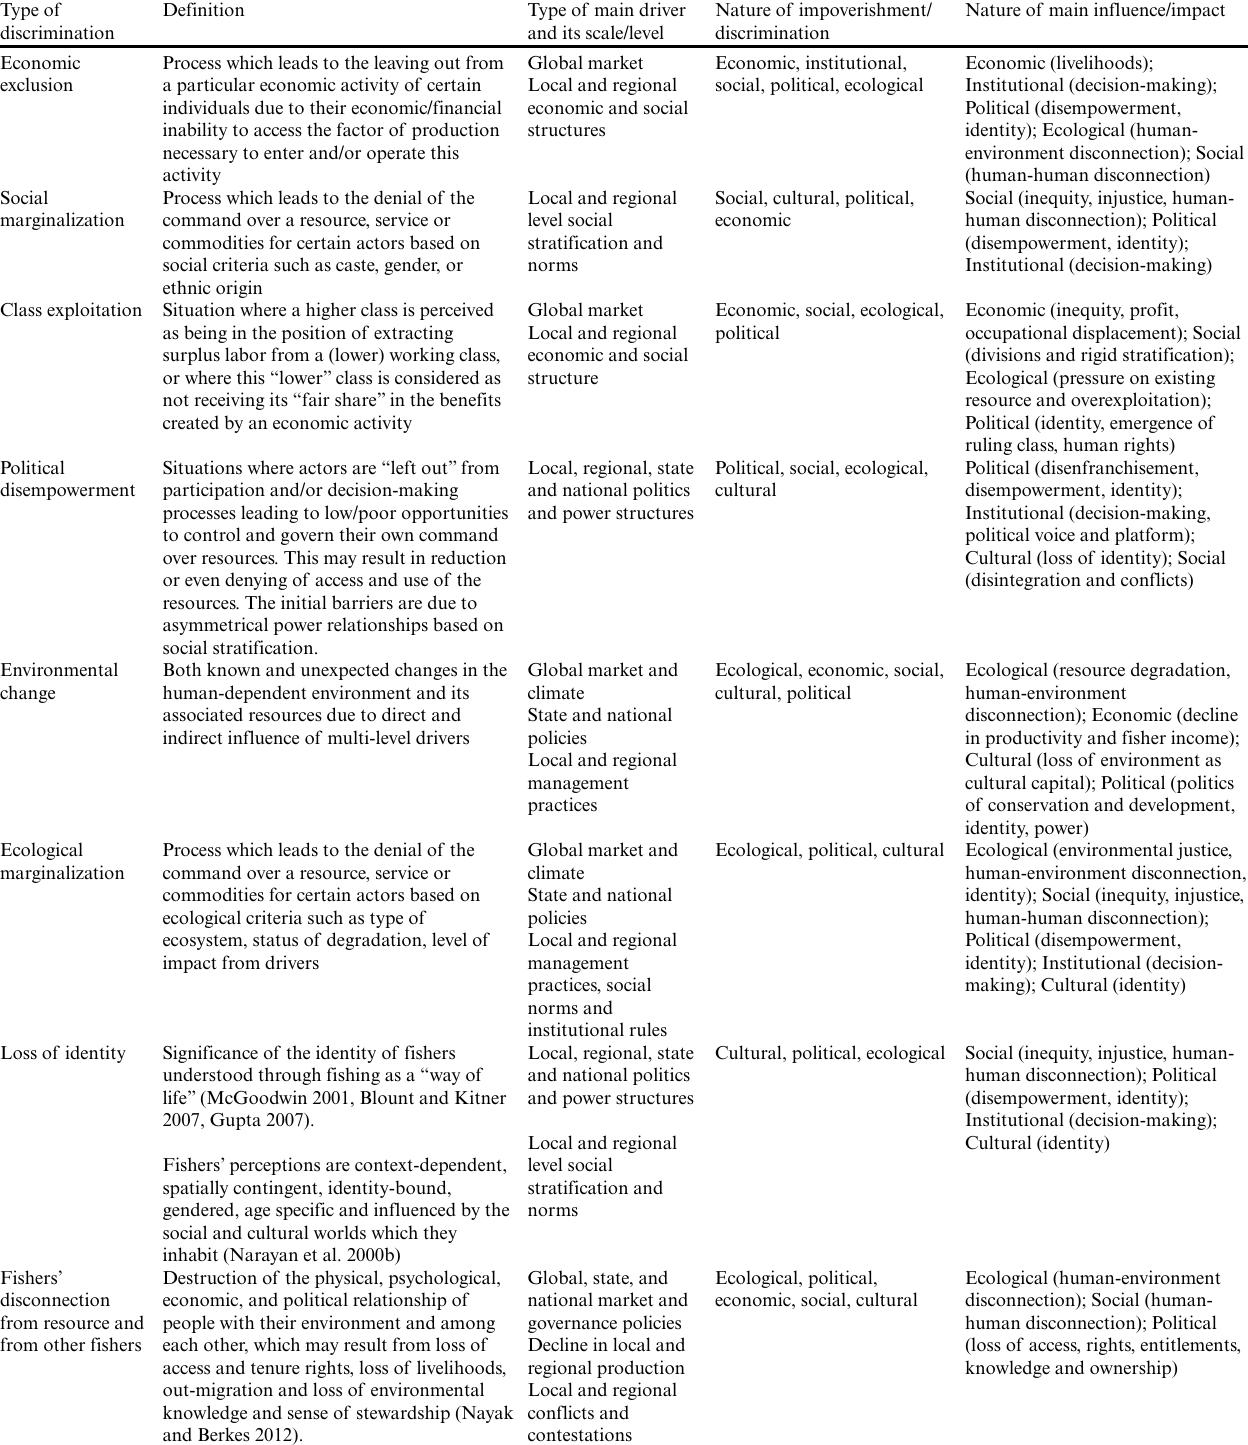
Table 1 . Extended typology of factors leading to impoverishment processes and poverty in small-scale fishery social-ecological systems. Source: adopted and modified from Bene